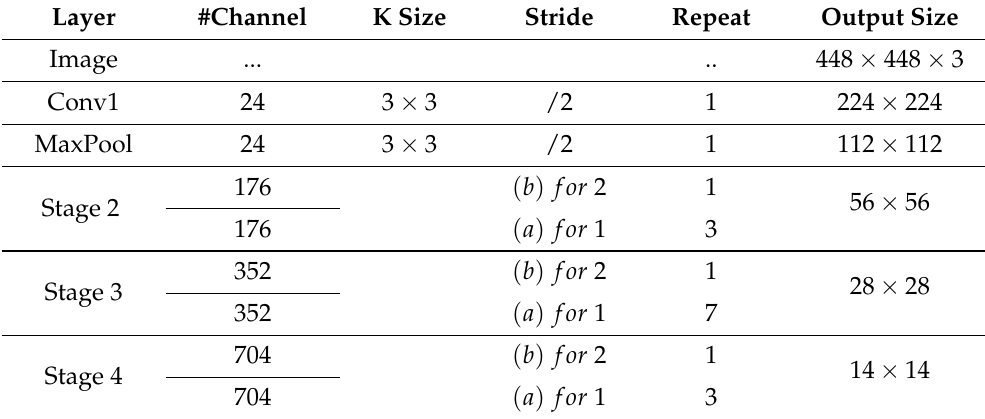
Table 1. Encoder path in our